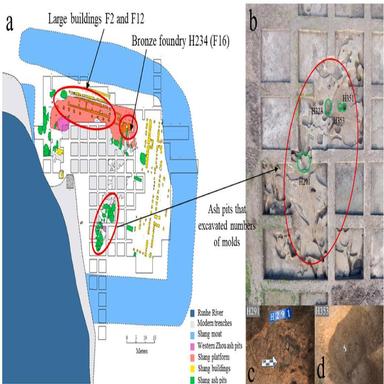
a): The plan of the Taijiasi site; b-d): The photographs of the ash pits revealing moulds (the picture modified from).